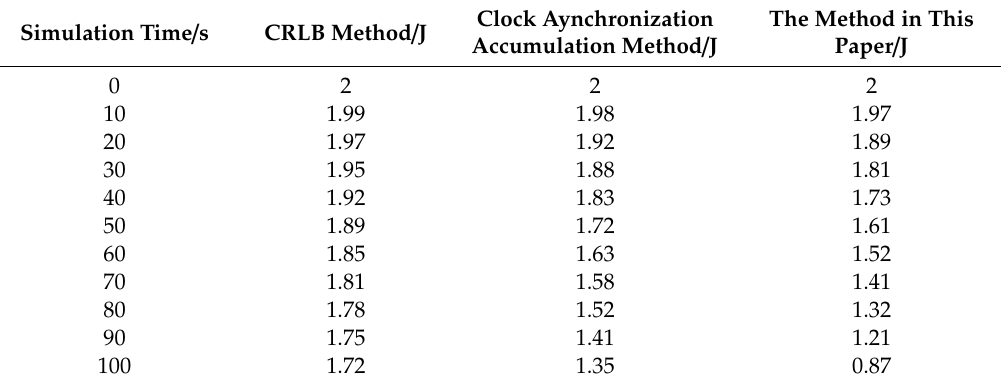
Table 2. Comparison of information overhead of different methods.